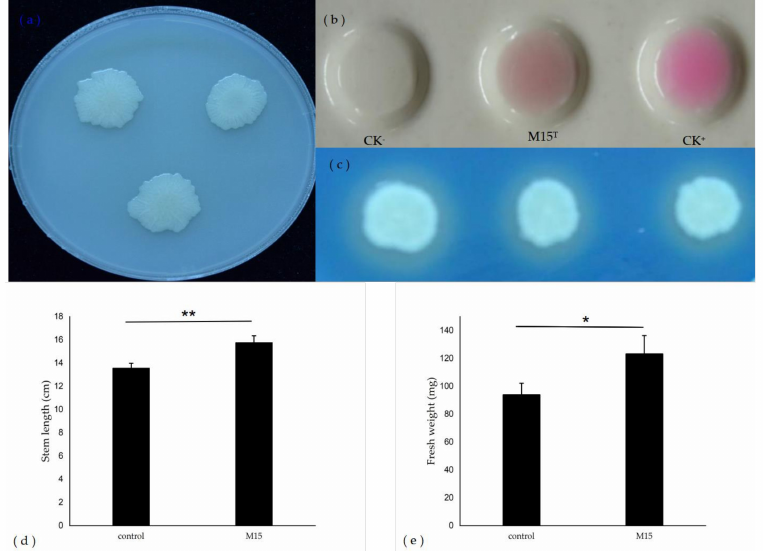
Figure 2. ( a ) Phosphate solubilization test in PKO medium; ( b ) detection of indole acetic acid production; CK − indicates the negative control using non-inoculated medium mixed with an equal volume of colorimetric; CK + indicates the positive control using 100 µ g / ml indole-3-acetic acid (IAA) standard mixed with an equal volume of colorimetric; ( c ) siderophore production with three repetitions; ( d,e ) E ff ects of strain M15 T on rice plant growth; d, e, indicate the e ff ects of strain M15 T on rice stem length and fresh weight (total weight of roots and stems), respectively. ** value is significantly di ff erent from the control, within each column (P < 0.01); * value is significantly di ff erent from the control, within each column (P < 0.05); Each treatment have at least three biological